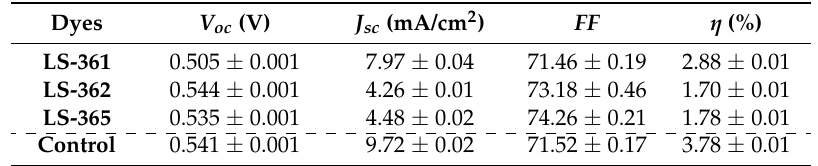
Figure 4. ( a ) J-V characteristics, ( b ) incident photon-to-current efficiency (IPCE) spectra, and ( c ) Nyquist plots in the dark of the dye-sensitized solar cells (DSSCs) sensitized with LS-361 , LS-362 , and LS-365 dyes. Those results of the Control (grey dotted line) are provided for comparison. The equivalent circuit model for EIS data fitting is inserted. Table 3. Dye-sensitized solar cell (DSSC) performance parameters of LS-361 , LS-362, LS-365 , and Control .